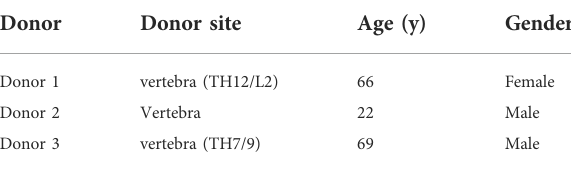
TABLE 1 Human sequences of self-designed oligonucleotide primers and probes used for real-time PCR analysis.